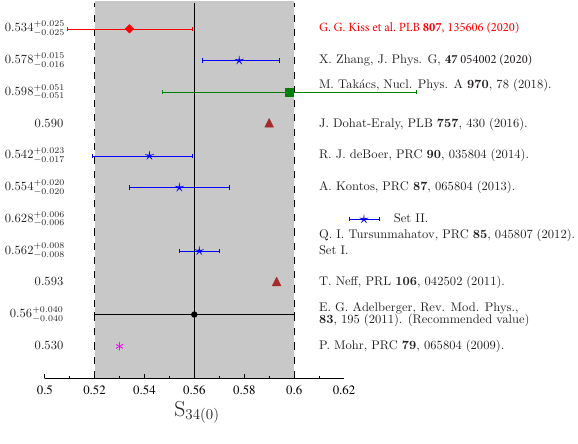
Figure 1. Summary of the most recent 3 He( α,γ ) 7 Be S 34 (0) factor results (fig.1 of [32]): derived from the analysis of elastic scattering angular distributions [22] (pink star), theoretical calculations [25, 30] (dark red triangle), extrapolations of experimental data sets [13, 23, 28, 29] (blue star), prediction based on neutrino yield measurement [31] (green box) and derived using the ANC technique [32] (red diamond). The solid central line represents the recommended value of [8], with its uncertainty indicated with the shaded area. For Tursunmahatov et al. [23], the S 34 (0) value obtained by fitting [10, 12, 14, 15] is